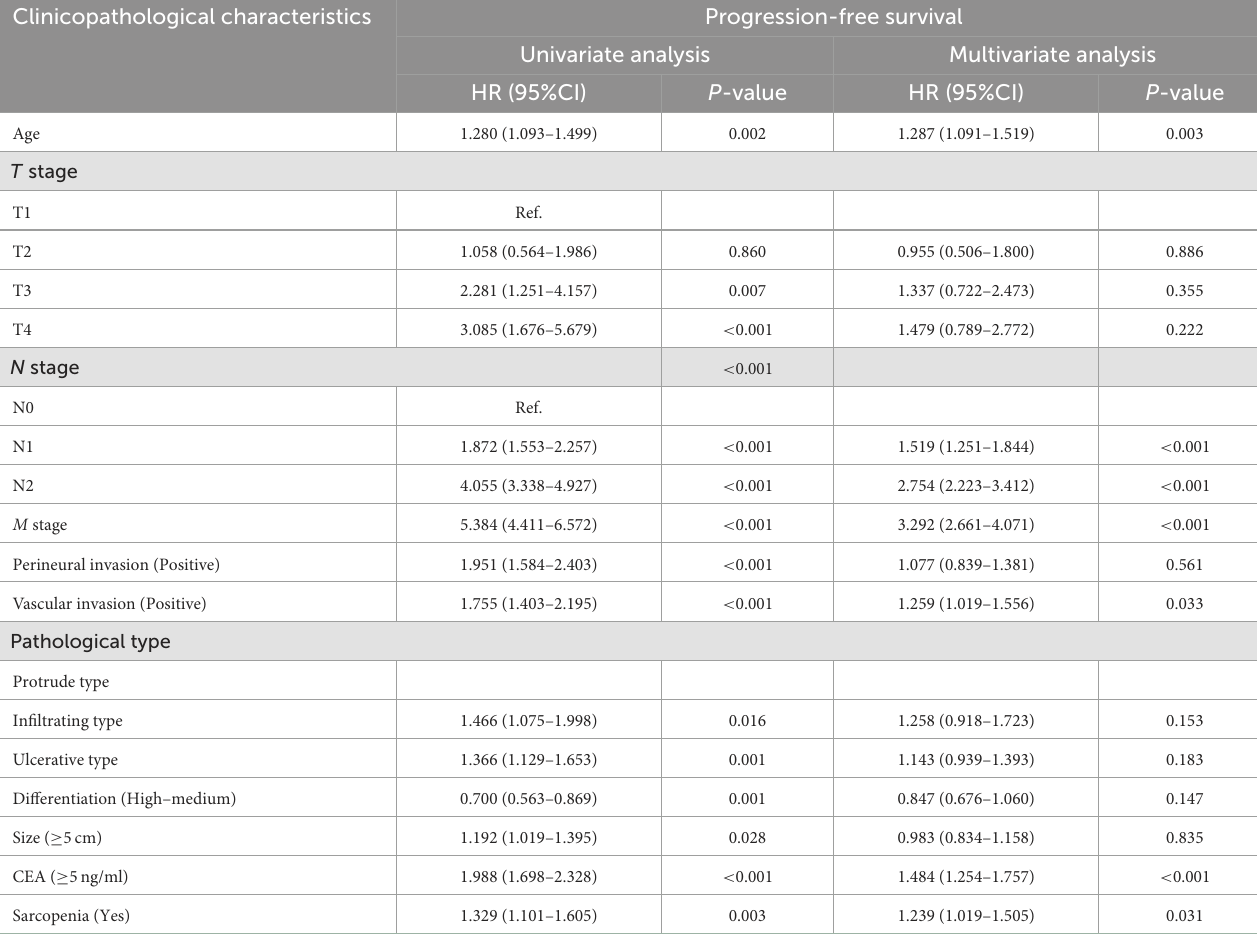
TABLE 2 Univariate and multivariate Cox regression analysis of clinicopathological characteristics associated with disease-free survival in CRC